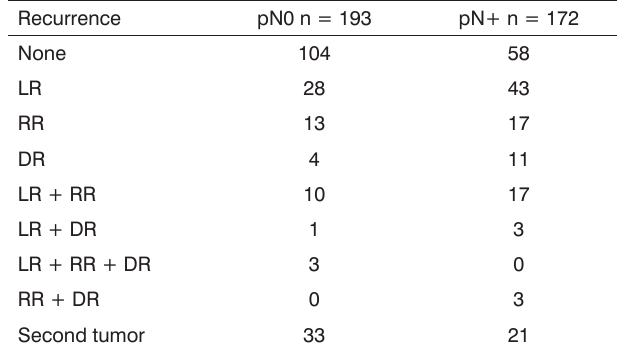
Table 1. Types of relapsing disease per pN stage.